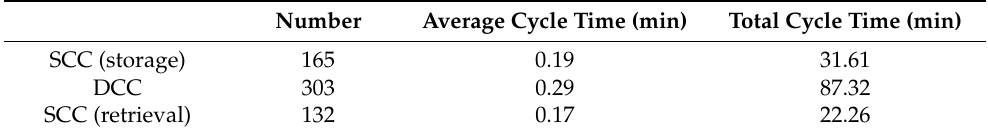
Table 2. Method 1 results (without reallocation).